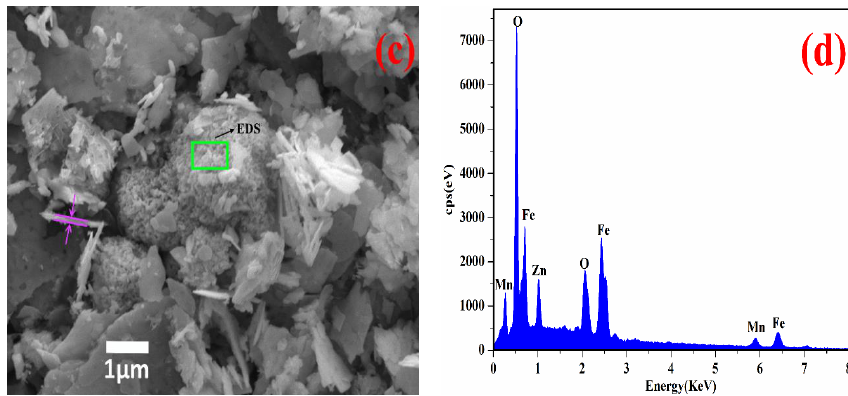
Figure 4. ( a ) SEM image of Bi 5 O 7 I; ( b ) SEM image of Mn x Zn 1 − x Fe 2 O 4 ; ( c ) SEM image of Bi 5 O 7 I/